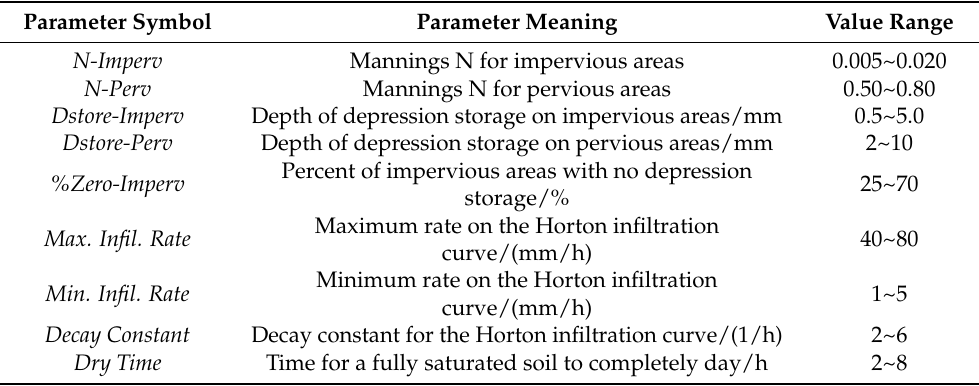
Table 1. Hydrological and hydraulic parameters in the SWMM model of the target area. Parameter Symbol